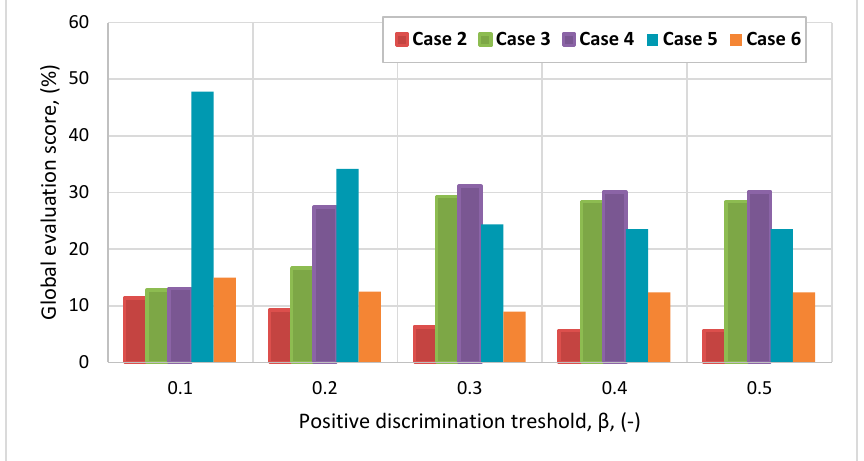
Figure 13. Global evaluation of the cases studied according to the positive discrimination threshold.